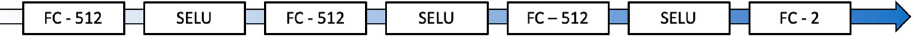
Figure A9. Illustration of the fully connected block mapping z i to y i . FC: fully connected layer with the number of nodes indicated.